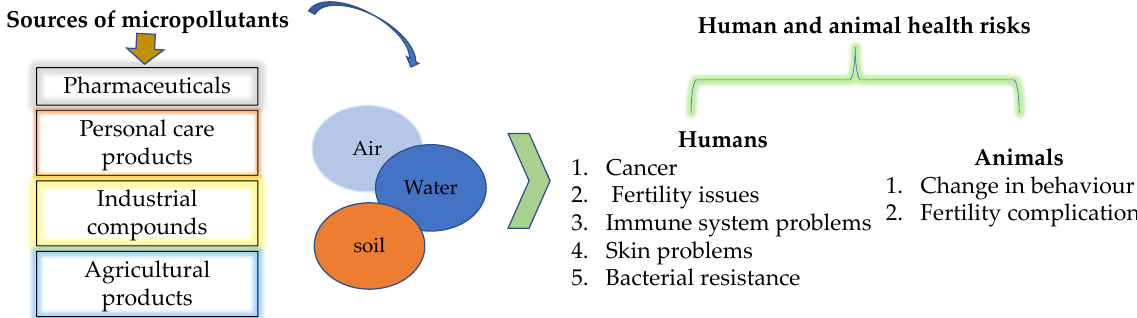
Figure 1. Some of the sources of micropollutants and their effects on humans and animals, as adapted from Vasilachi et al. [51].